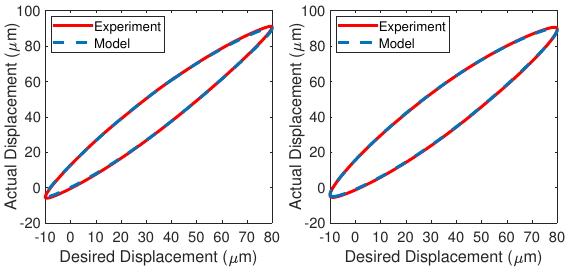
Figure 4. Hysteresis loops generated by the experiment and the model (30 rad/s with the left subfigure and 50 rad/s with the right